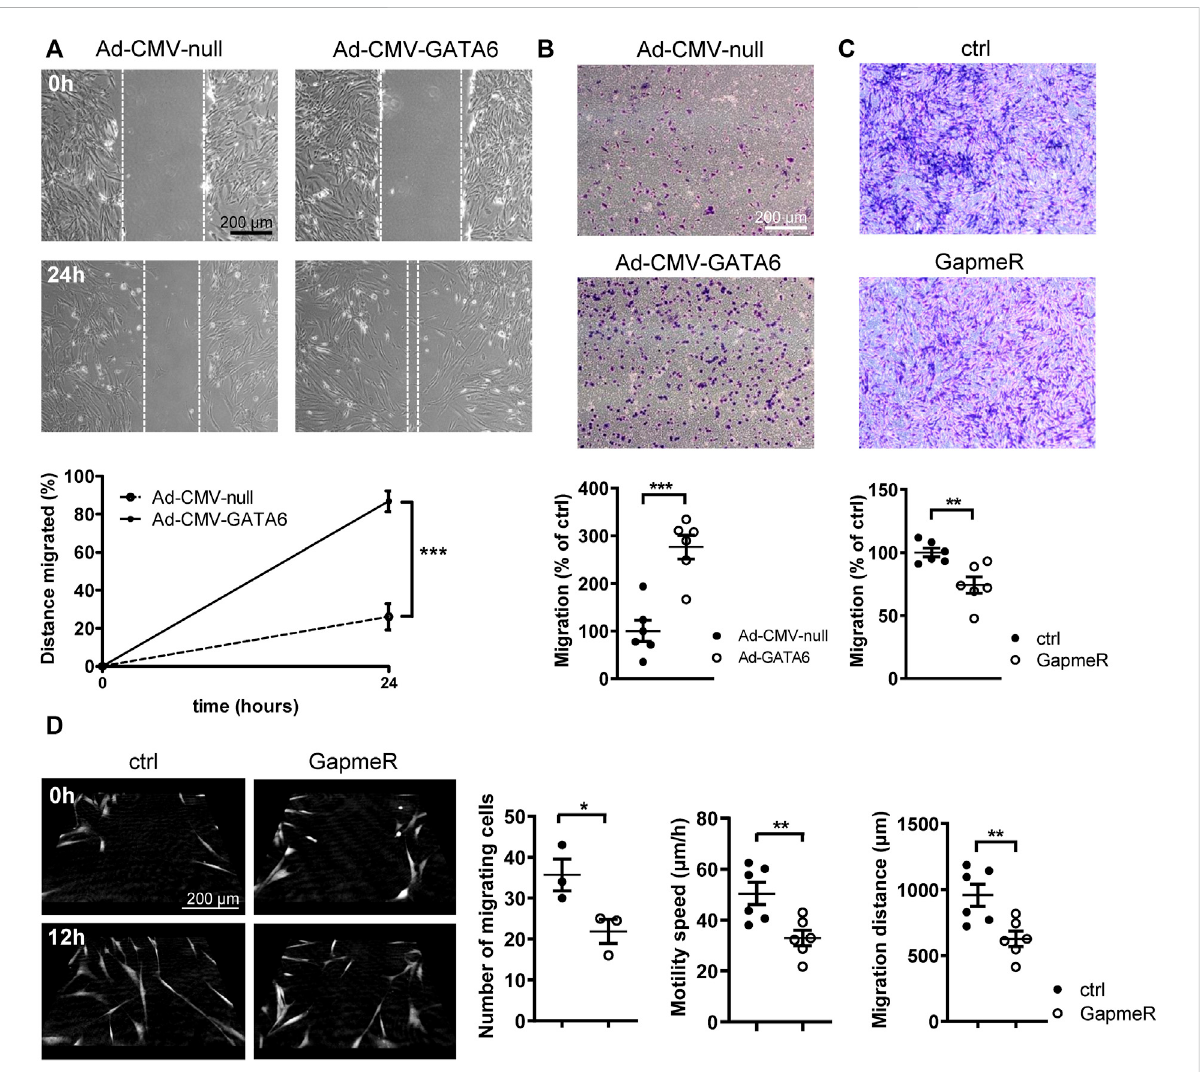
FIGURE 2 GATA6 promotes migration of human vascular smooth muscle cells. Human coronary artery smooth muscle cells were transduced with Ad- CMV-GATA6/Ad-CMV-null or transfected with GapmeRs against GATA6. Cell migration was assessed using a (A) wound-healing assay, (B,C) transwell migration assay (24 h). (D) Digital holographic cytometry was used to measure migration of human coronary artery smooth muscle cells afterGapmerRstransfectiontodownregulateGATA6.Photosweretakenattheindicatedtimepoints. Numberofmigrating cellswereanalyzed after 24 h. Migration speed and distance after 19 h. Data are presented as mean ± SEM ( n = 3 – 6). * p < 0.05, ** p < 0.01, *** p <